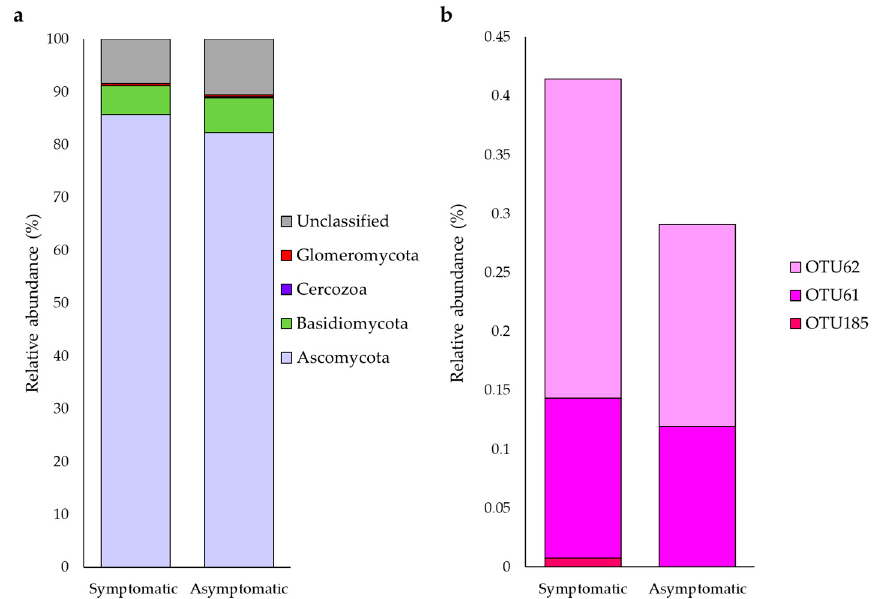
Figure 4. Phylum composition of the fungal community ( a ) and change in abundance of OTU assigned to Glomeromycota phylum ( b ) related to AMF, associated with pool of DNA from asymptomatic and symptomatic grapevine to esca.